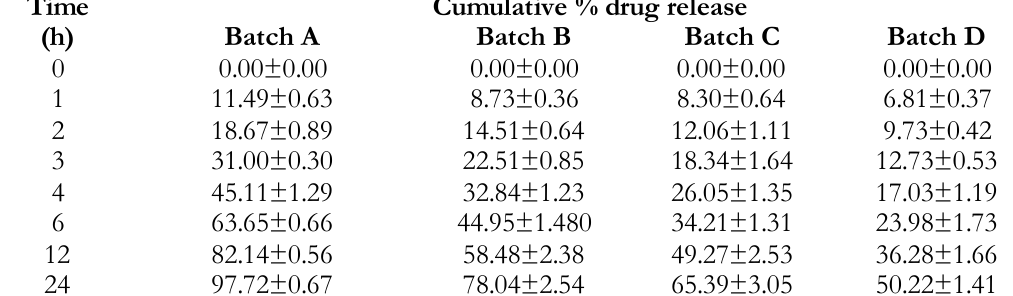
Table IV. In vitro transcorneal permeation study Time